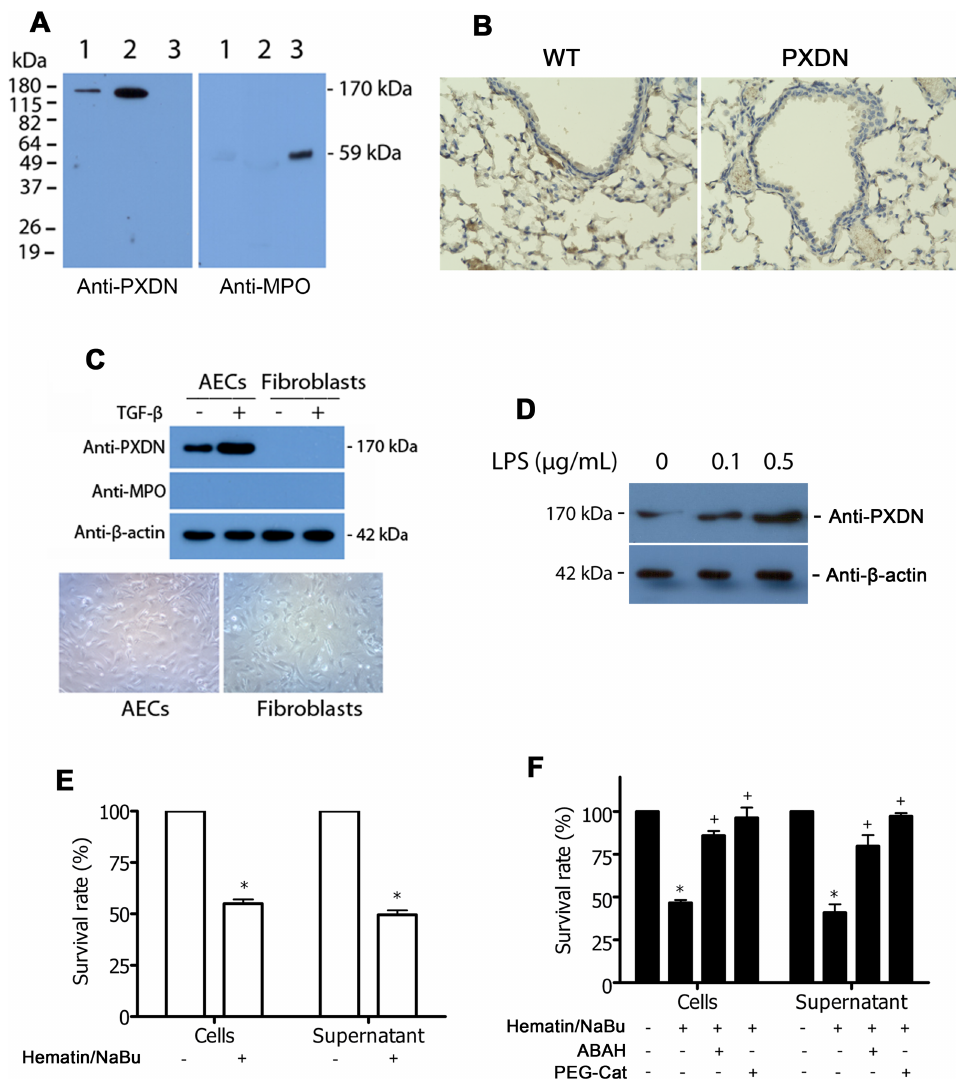
Fig 4. PXDN is expressed in the lung epithelium and contributes to bacterial killing. (A) Detection of PXDN in human bronchoalveolar lavage fluid (BALF). Right middle lobe BALF was collected and processed within 2 h. BALF samples were then centrifuged at 400 x g for 10 min at 4˚C. BALF were concentrated by Centricon (~10x). Samples of BALF (1), positive control of human plasma containing ~100 ng of PXDN (2), and purified MPO (50 ng) (3) were subjected to immunoblotting using anti-PXDN or anti-MPO antibodies. (B) IHC of the lung. IHC of lung sections from WT and PXDN-deficient mice was performed using anti-PXDN antibody (1:600). Images were taken using BZ-X710 All-in-One Fluorescence Microscope. PXDN: dark brown. Magnification: 400x. (C) PXDN expresses in mouse primary lung type II alveolar epithelial cells (AECs). Upper panel showed immunoblot analysis of AECs and fibroblasts while lower panel showed phase contrast microscopy of AECs (left) and fibroblasts (right); magnification 100x. Cell lysates were subjected to conventional immunoblotting by using anti-PXDN antibody. β -actin was used as loading control. (D) LPS induces PXDN expression. AECs were induced by LPS as indicated. The cell lysates were subject to immunoblot analysis as in ( C ). (E) Mouse primary type II AECs mediate P . aeruginosa killing. AECs were grown in 12-well plate in DMEM with 10% FBS without antibiotics until 70% confluence. Cells were serum-starved for 16 h prior to bactericidal assays; cells were stimulated with/without TGF- β and hematin/NaBu. Cells and the overlying medium (supernatant) were separated and utilized for evaluation of PXDN-mediated bactericidal killing. 1 mL of fresh DMEM containing 10 4 P . aeruginosa strain K and 10 μM H 2 O 2 was added to AECs or supernatant. The mixture was incubated at 37˚C for 1 h, and then plated on LB agar plates prior to overnight incubation at 37˚C. The control group contained untreated AECs and P . aeruginosa . The relative survival rate was calculated as CFUs in the experimental group divided by those in the control group; (cid:3) P < 0.001 vs . Control. (F) Inhibition of AEC-mediated P . aeruginosa killing by peroxidase inhibitors. The experiments were carried out as in “E” with addition of ABAH (broadly specific inhibitor of heme-containing peroxidases) or PEG-catalase (which reduces H 2 O 2 ). (cid:3) P < 0.001 vs . Control; + P < 0.001 vs . hematin/NaBu. Data are representatives of three independent